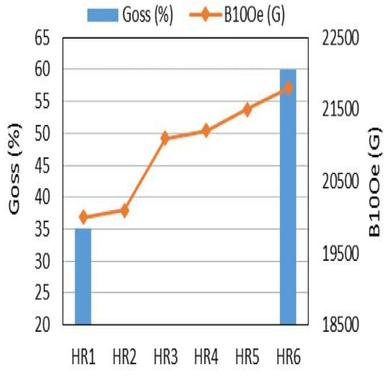
Evolution of the magnetic induction B10Oe and Goss fraction of samples after A5 annealing with different initial hot rolling conditions.